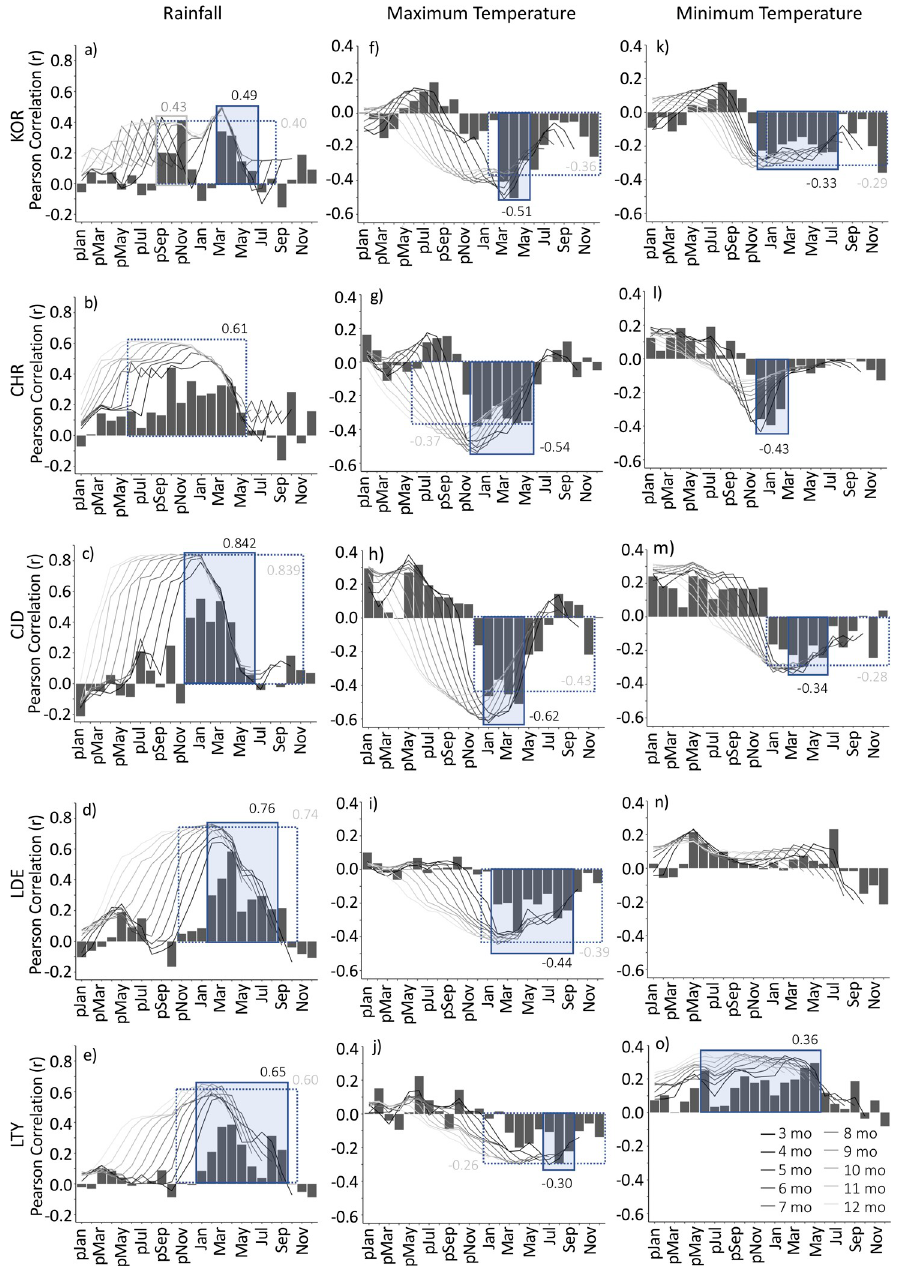
Fig 2. Pearson correlations between ring-width index (RWI) and monthly (columns) and seasonal (lines) rainfall (a- e), maximum (f-j) and minimum temperatures (h-o) at each of the five Callitris columellaris sites. The x-axis indicates the starting month of the seasonal period while the colours of the lines correspond to the length of the seasonal period (the number of consecutive months) rainfall was summed over or temperature was averaged over. Shaded boxes indicate the ‘best’ (highest correlation) season; dashed boxes indicate the best annual period for each site. Numbers inside or next to boxes are the Pearson correlation values for the respective season or annual period. Lower case ‘p’ indicates months in the calendar year prior to the main growing season. LDE showed no significant correlation between RWI and minimum temperature for any period > 3 months.